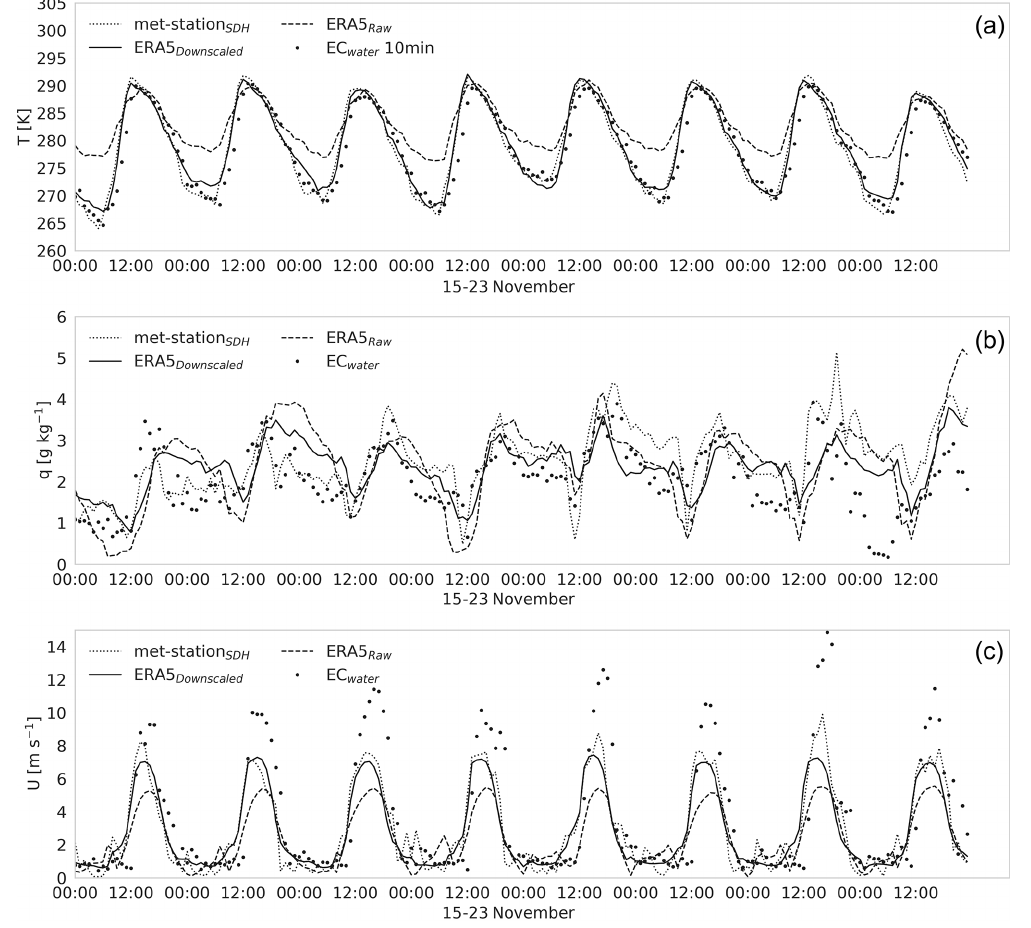
Hydrol. Earth Syst. Sci., 26, 3709–3729, 2022